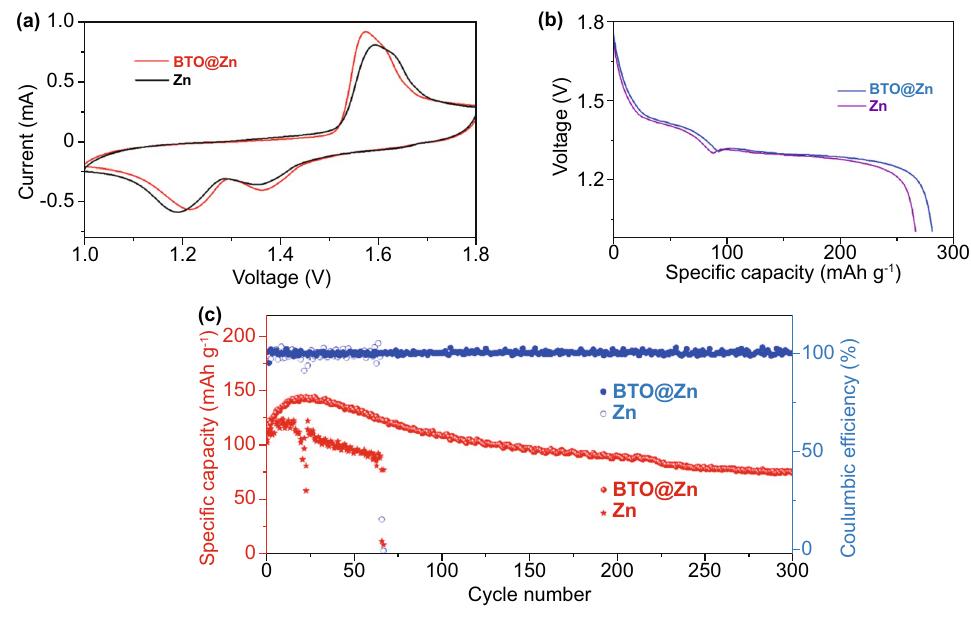
Fig. 4 Electrochemical performance of Zn–MnO 2 batteries based on bare Zn and BTO@Zn foil, respectively. a CV profiles of the 2nd cycle at 1 mV s −1 . b GCD curves of the 2nd discharge process at 200 mA g −1 . c Cycling performance at 2 A g